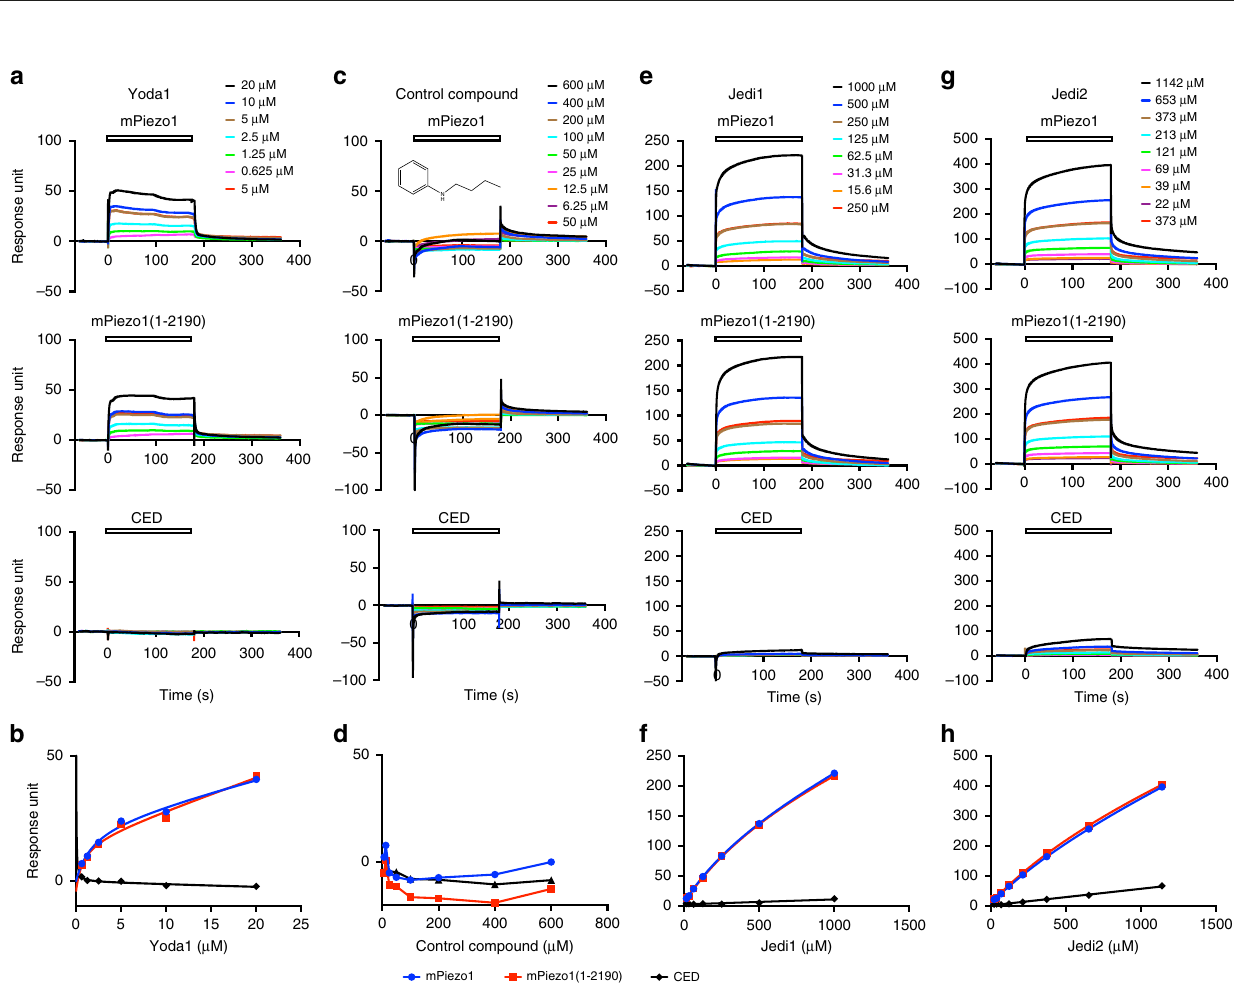
Fig. 4 Jedi1/2 and Yoda1 bind to the fragment of residues 1 – 2190. a , c , e , g Representative SPR traces of the immobilized puri fi ed mPiezo1 (top panel), mPiezo1(1 – 2190) (middle panel), and CED (lower panel) in response to the series of concentrations of the indicated compounds measured with the af fi nity mode. To validate the reproducibility of the immobilized proteins regenerated after each dose point, a same dose (5, 50, 250, and 373 μ M for Yoda1, control compound, Jedi1, and Jedi2, respectively) was re-tested. As exempli fi ed in e , the red line overlaps with the brown line, indicating the reproducibility of the immobilized proteins for the assay. b , d , f , h The resulting dose-binding curve of the indicated compounds to the indicated proteins. The curves in b , f , and h were fi tted with a total-binding equation. Similar results were obtained from two to eight independent experiments